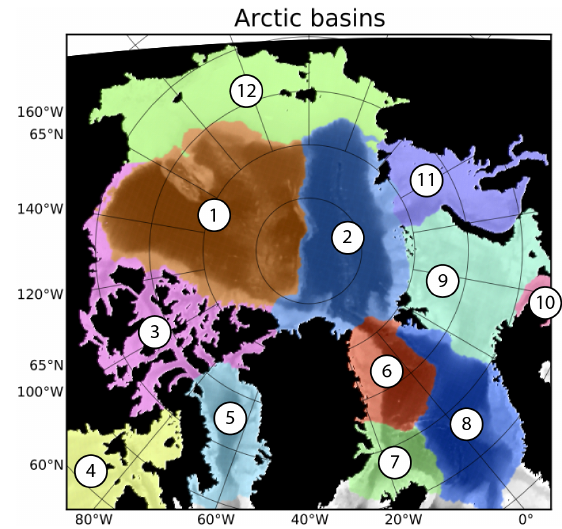
Figure 3. Division of Arctic Ocean and adjacent regions for average Rossby radius calculations; see Table 1 for identification of sub- regions by key number.